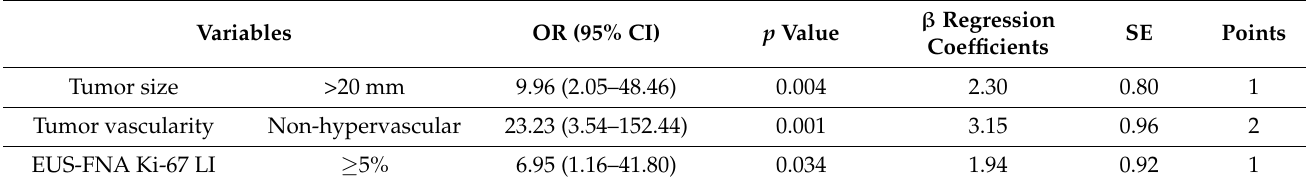
Table 4. Multivariate stepwise logistic regression analysis of selected variables.